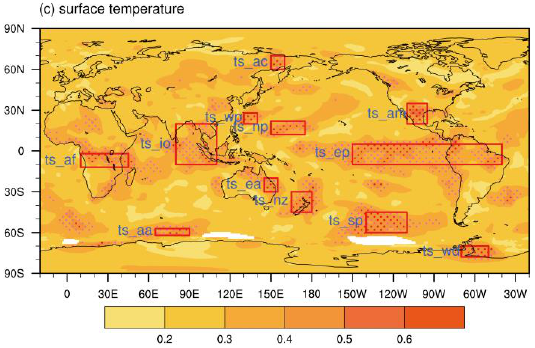
Figure 2. The distance correlation between TPTT and boreal spring SIC ( a ), SC ( b ), and TS ( c ) from 1967 to 2010. The pink and red dots indicate the 95% and 99% Monte Carlo tests. The red boxes are the selected feature regions, and the blue text to the left of the red box is the abbreviation of each feature. The sic_s means the feature is selected from SIC in South Hemisphere. And the definition of other features are similar as follows: SC in Eurasia (sc_ea), SC in the Tibetan Plateau (sc_tp), TS in Arctic (ts_ac), TS in western Pacific (ts_wp), TS in northern Pacific (ts_np), TS in America (ts_am), TS in Africa (ts_af), TS in Indian Ocean (ts_io), TS in eastern Pacific (ts_ep), TS in eastern Australia (ts_ea), TS in New Zealand (ts_nz), TS in Antarctica (ts_aa), TS in South Pacific (ts_sp), TS in Weddell Sea (ts_wd).